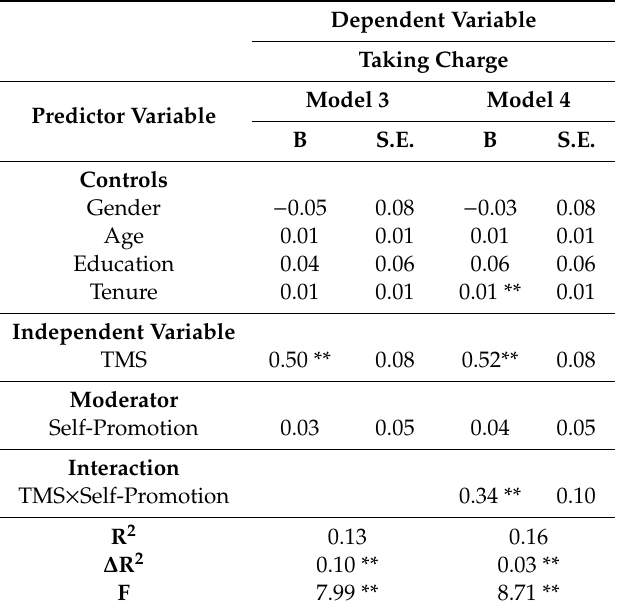
Table 5. Regression results for testing moderation e ff